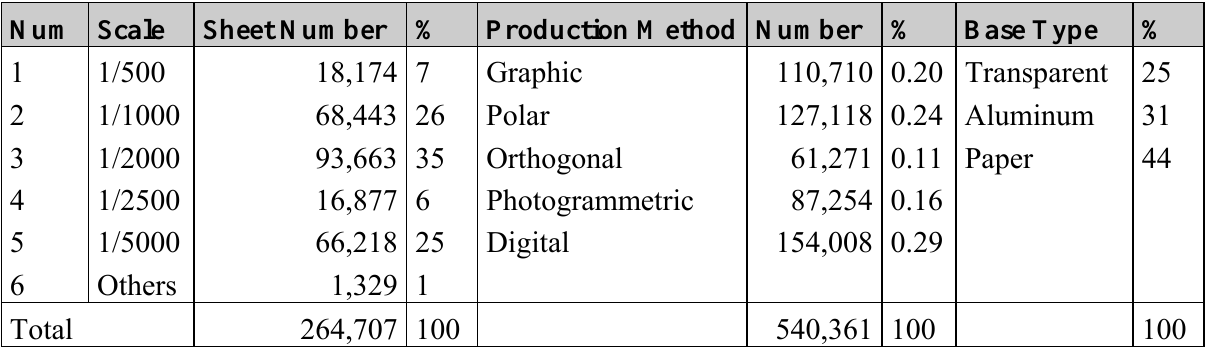
Table 1. Turkish cadastral maps according to scales, production methods and sheet bases [7].